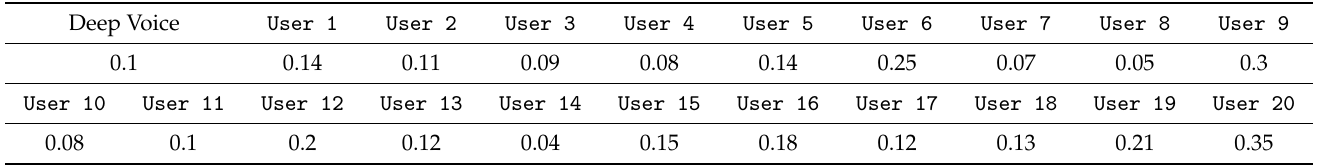
Table 5. EER for user authentication in test dataset.